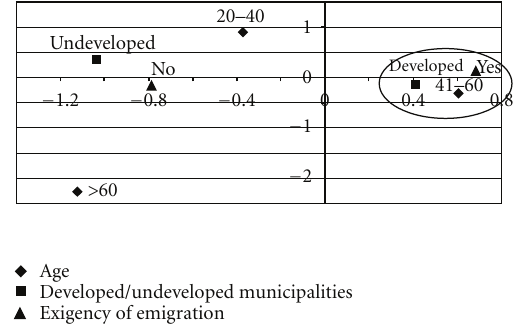
Figure 7: Multiple correspondence analysis for “exigency of emi-